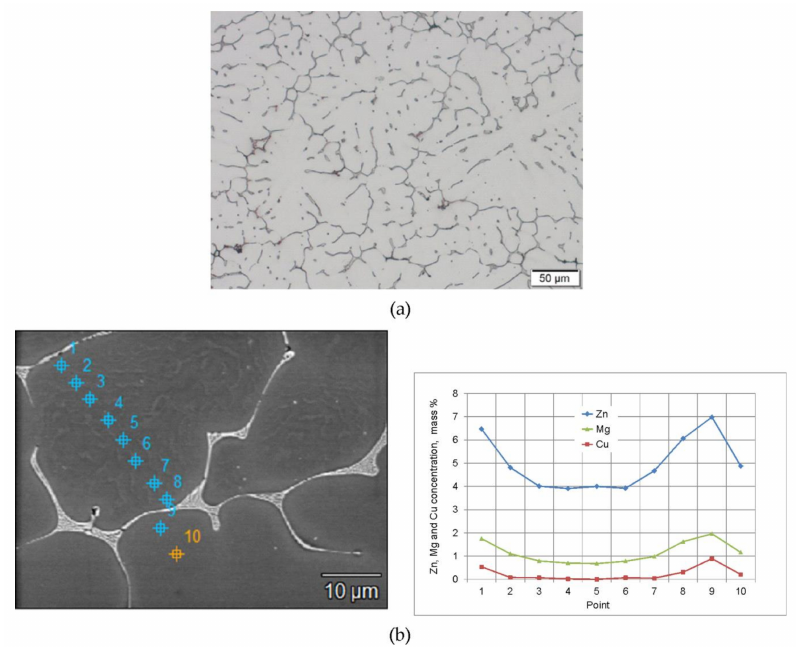
Figure 2. Microstructure of 7075 alloy 3 in the as-cast state: ( a ) optical microscope photograph; ( b ) SEM image with marked analysis points and distribution of main additions across